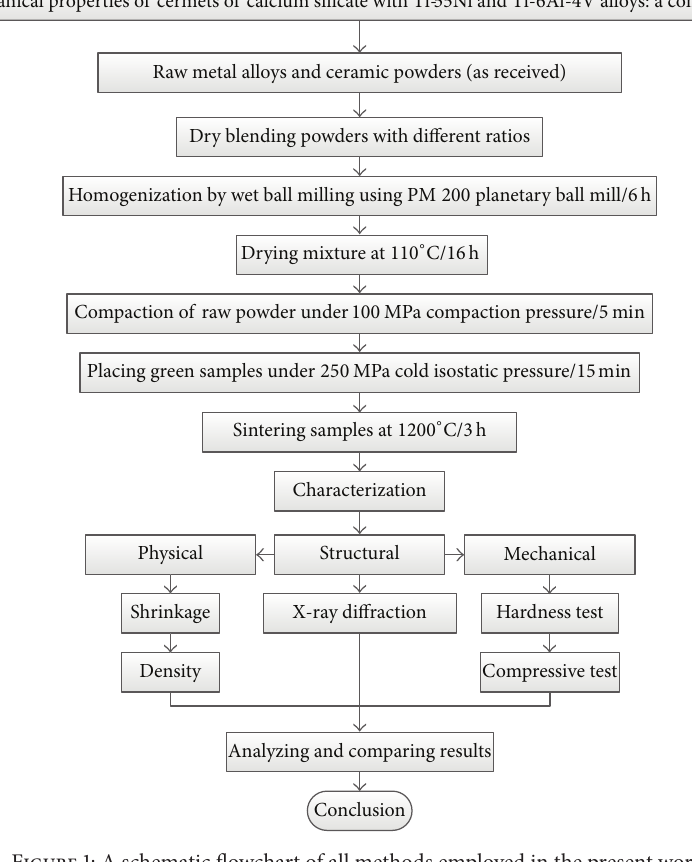
Figure 1: A schematic flowchart of all methods employed in the present work.